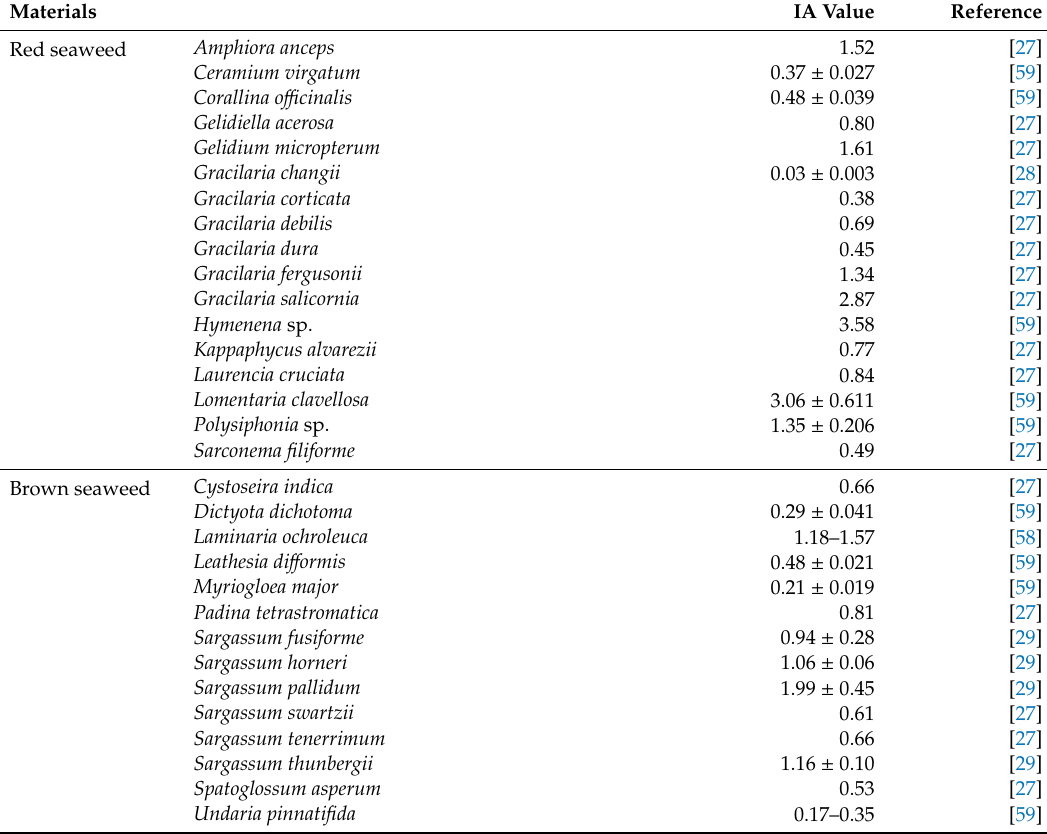
Table 3. Application of IA in fatty acid evaluation